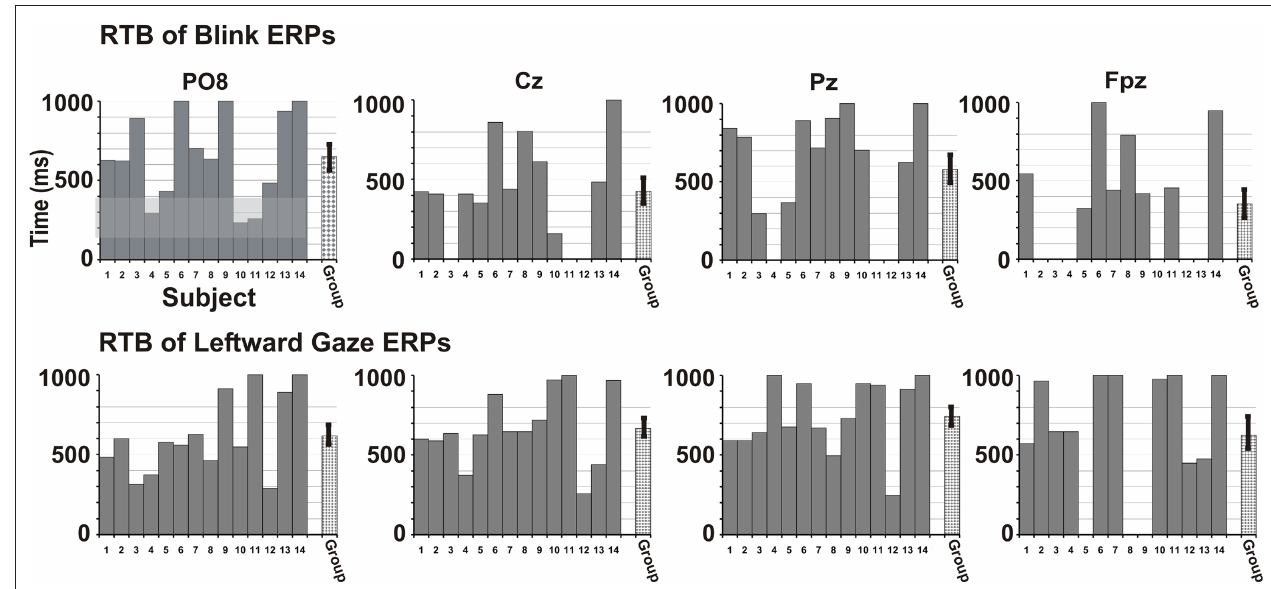
points (20 ms) with a t -value greater than 1.68 (based on a df = 40, p < 0.05). All participants had significant early peaks at temporo-occipital electrodes (up to ∼ 200 ms, see gray shaded region for P08), but not all participants had later peaks, or peaks at more anterior electrodes, especially for the Blink condition. The final bar indicates a group average RTB with SE. RTB values are shown for electrodes analogous to 10–10 system sites PO8, Cz, Pz,